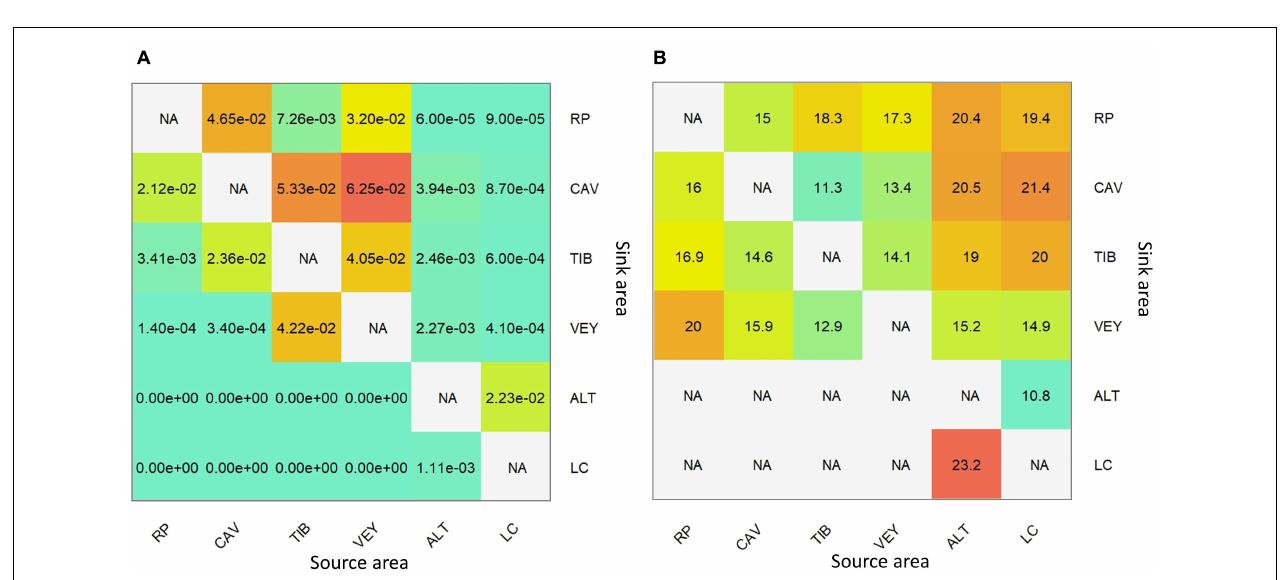
FIGURE 5 | Principal component analysis (Axes 1 and 2) computed using the set of 10,755 putative neutral SNPs (A) with all individuals ( n = 229) and (B) restricted to individuals ( n = 143) sampled from the Bay of Marseille, Cassis to La Ciotat.